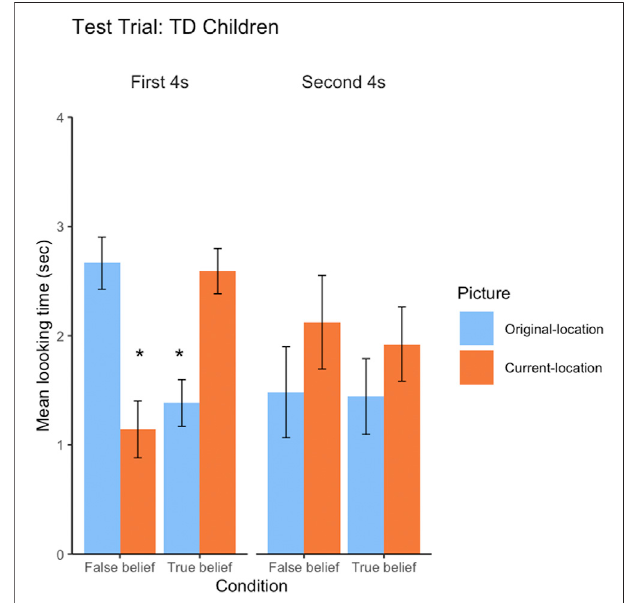
FIGURE 2 | TD children ’ s mean looking time (in seconds) to the pictures in the test trial, separately by condition and window. Error bars represent standarderrorsandasterisksindicateasigni fi cantdifferenceinlookingtimeto the two pictures within a condition ( p < 0.05).